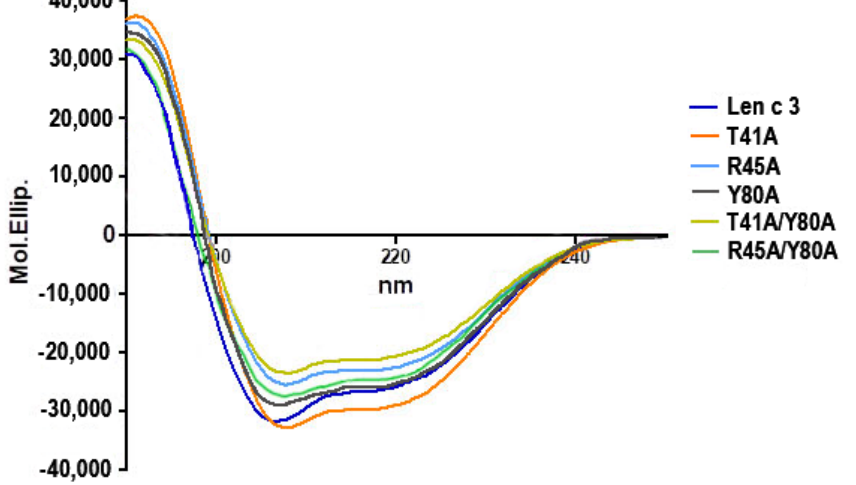
Figure 1. Overlay of the CD spectra of Len c 3 and its mutant analogues (T41A, R45A, Y80A, T41A/Y80A, R45A/Y80A), measured at 25 °C.